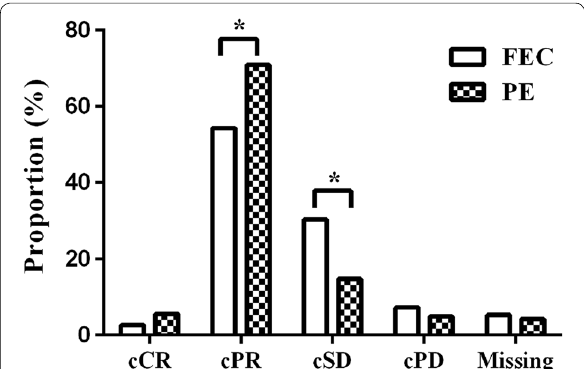
Fig. 2 Final assessment of clinical responses of patients with locally advanced breast cancer to neoadjuvant chemotherapy (FEC